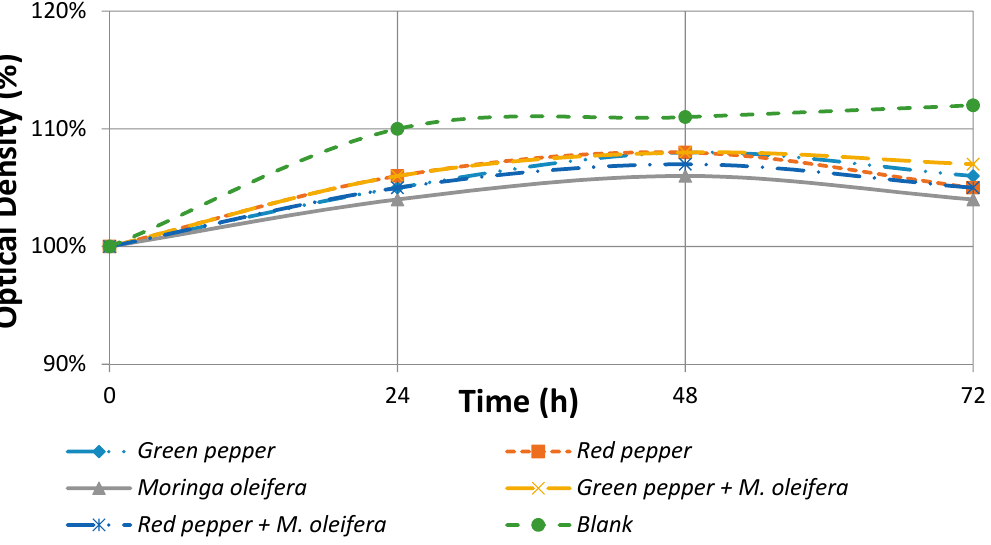
Figure 2. Changes in turbidity (optical density) of MEs at 35 °C during 0, 24, 48, and 72 h.